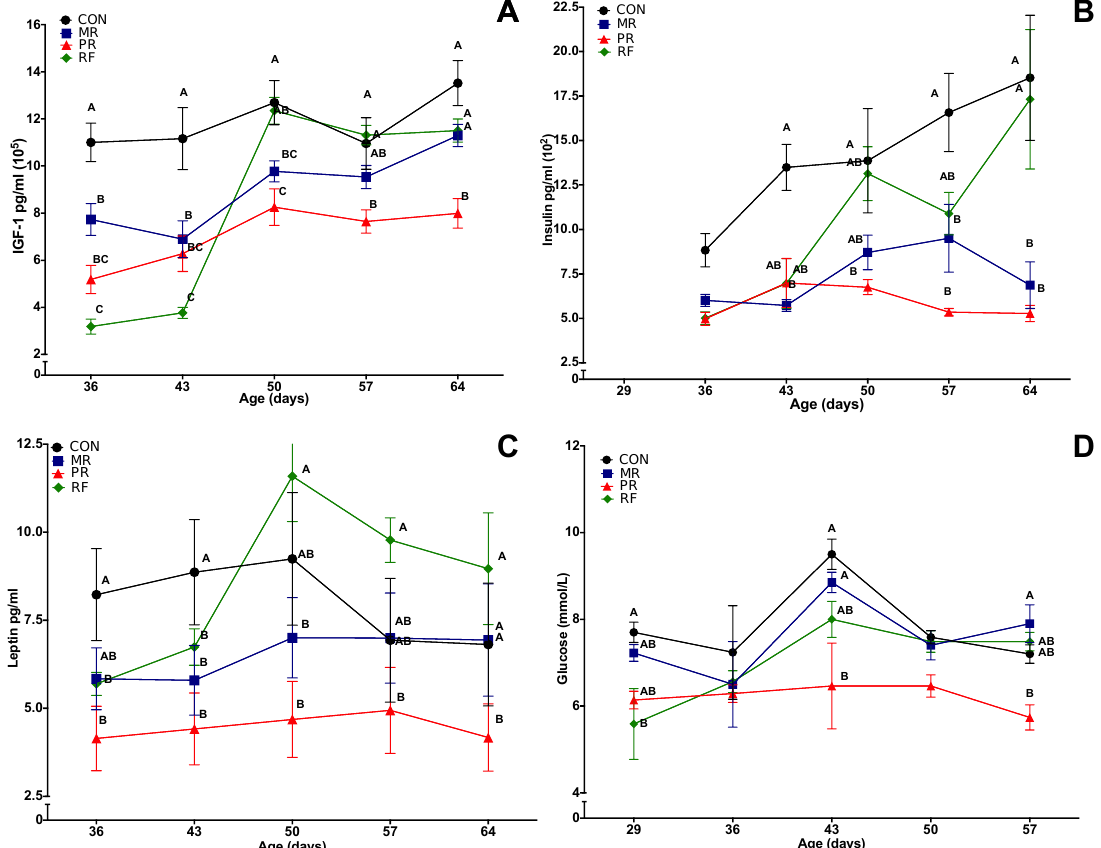
Figure 2. Mean (± SEM) effects of feed restriction and refeeding on plasma concentrations of metabolic hormones in rats ( n = 8 / group): ( A ) insulin-like growth factor-1 (IGF-1); ( B ) insulin; ( C ) leptin; and ( D ) glucose. CON (Control), ad libitum feeding; MR (Mild Restriction), 75% of CON intake; PR (Profound Restriction), 50% of CON intake; and RF (Refeeding group), 50% of CON intake for 14 days, and then ad libitum. Treatment, time and treatment by time interaction were significant ( p < 0.001) for all three hormones and for glucose. A–C Within a day of age, groups without a common superscript differed ( p < 0.05).